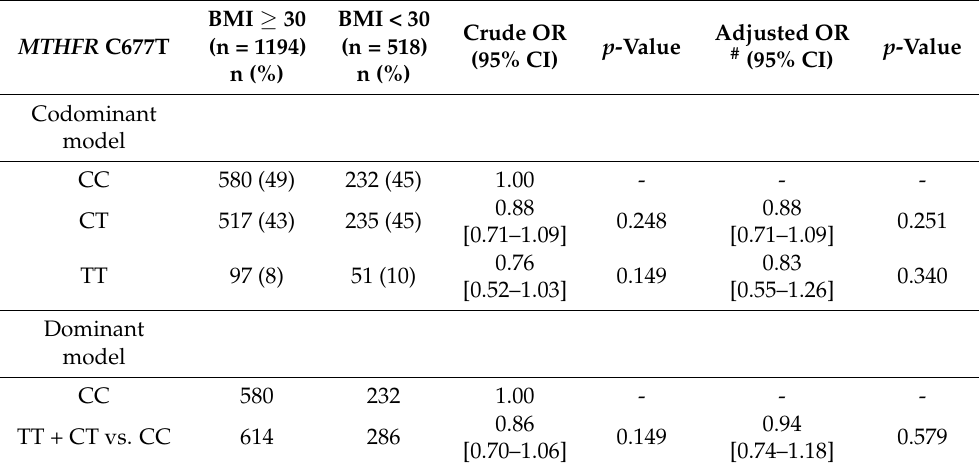
Table 3. Association of the MTHFR C677T polymorphism with obesity